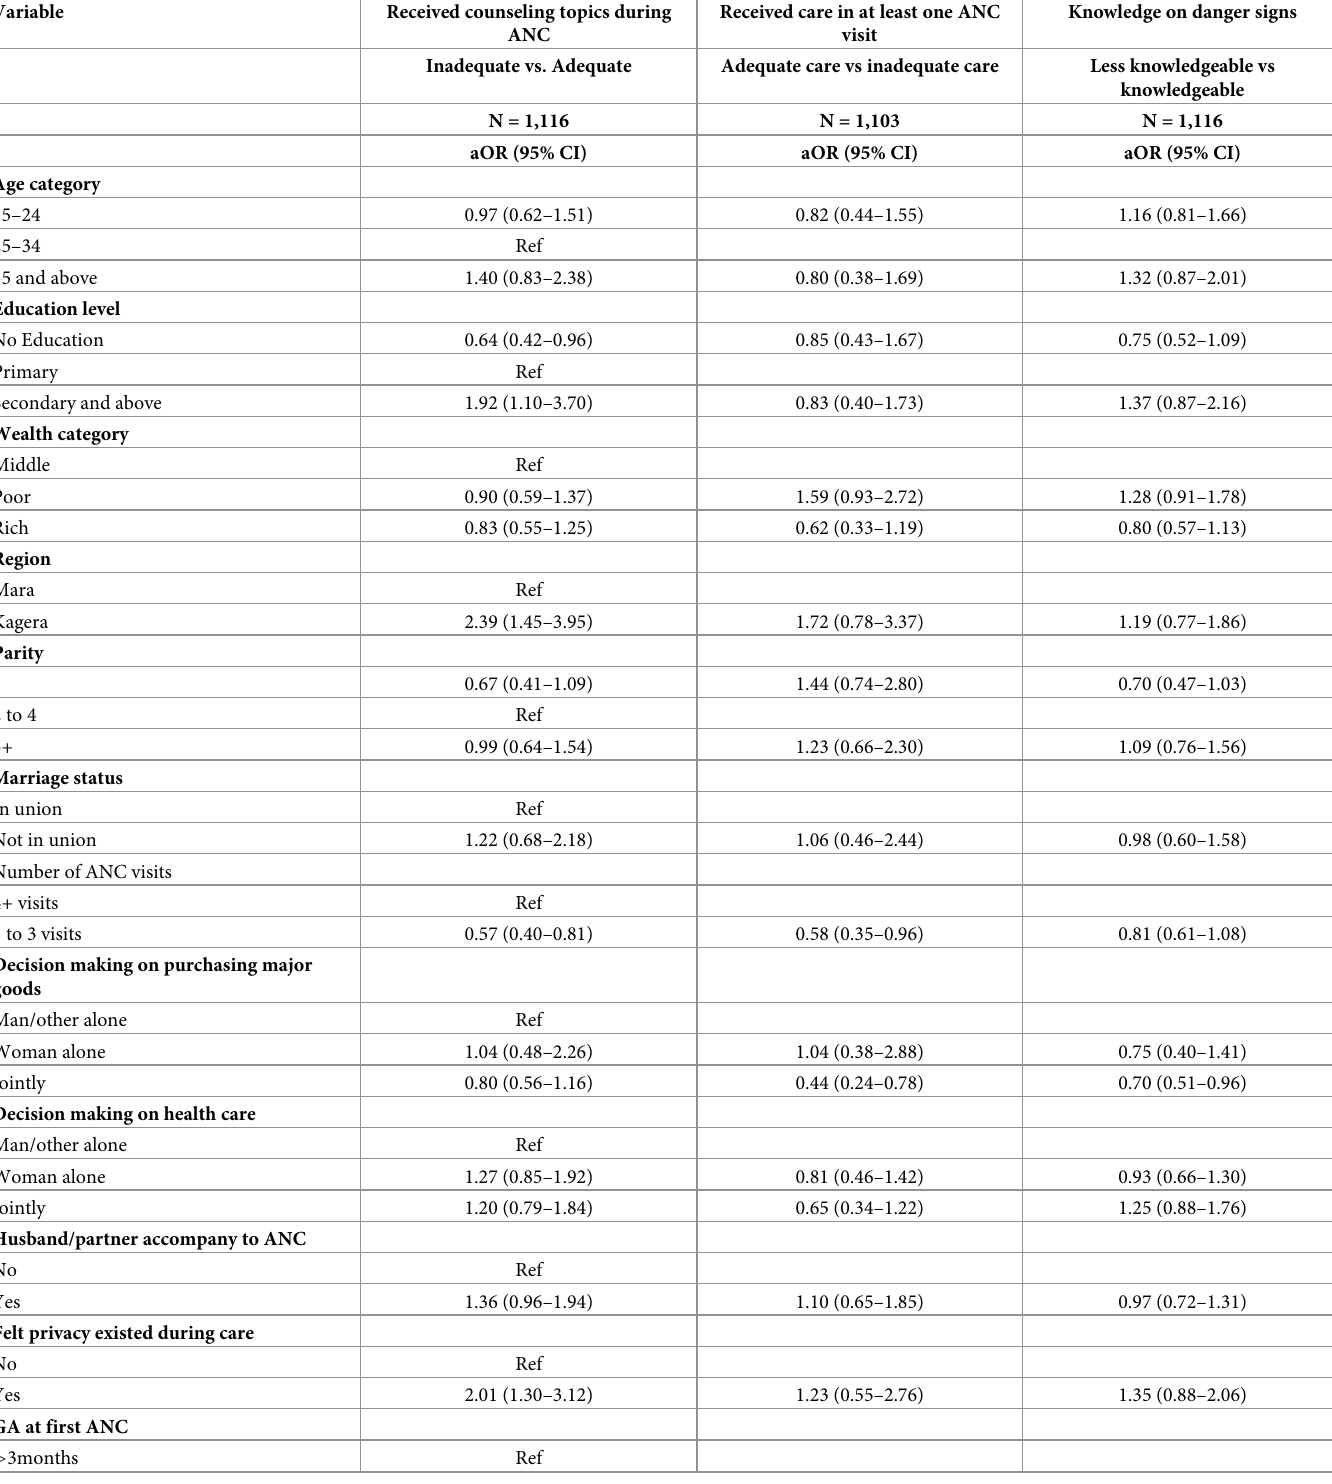
Table 4. Mixed effect logistic regression analysis examining factors associated with receiving ANC components (number of counseling topics, received care in at least one ANC visit, and women’s knowledge on danger signs) in Mara & Kagera *